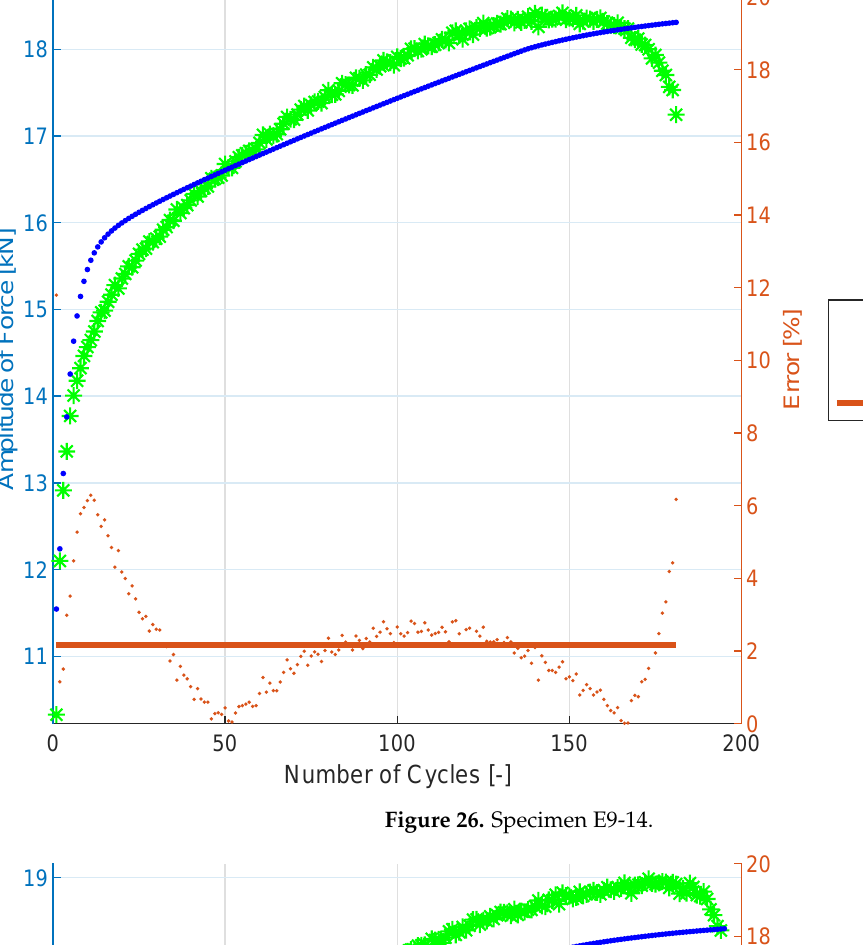
Figure 26. Specimen E9-14.